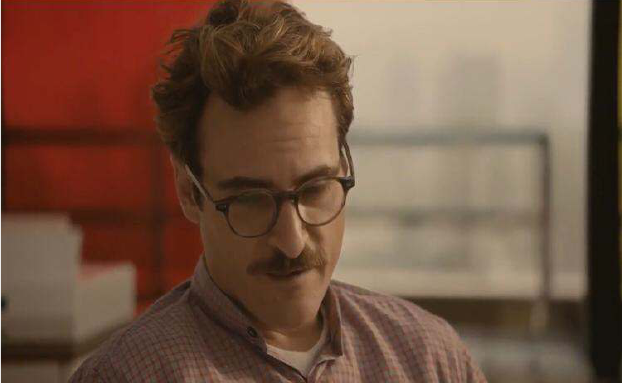
Figure 4. Theodore could not